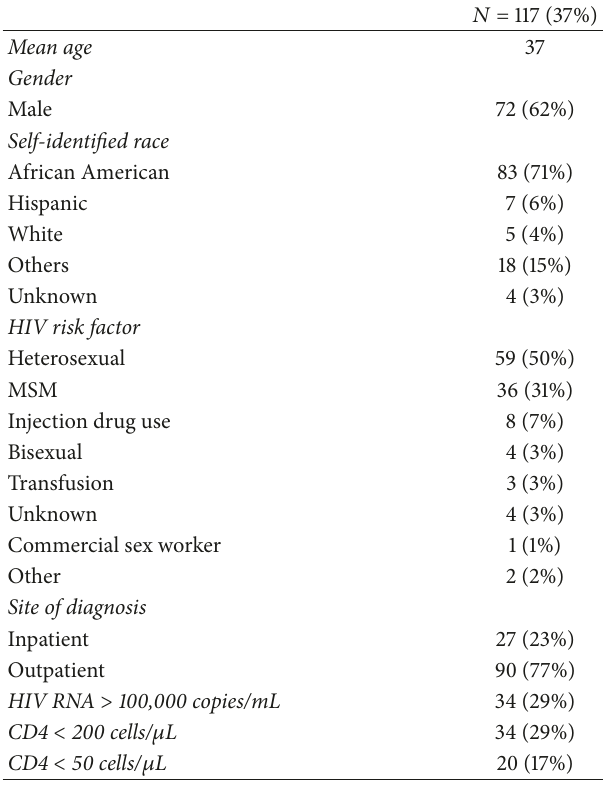
Table 1: Baseline characteristics of newly diagnosed HIV patients